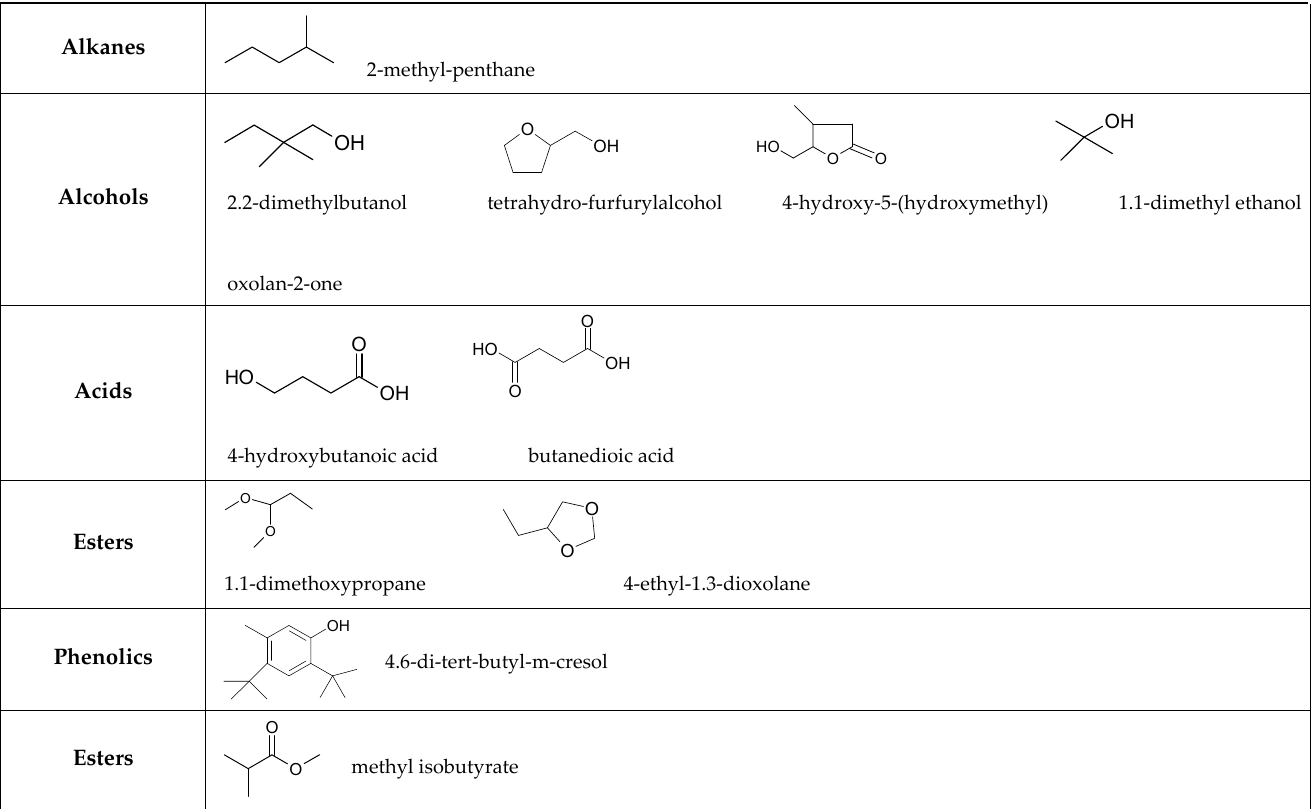
Figure 15. GC-MS spectrum of the humins oil (from the hydrodeoxygenation reaction in the presence Figure 15. GC ‐ MS spectrum of the humins oil (from the hydrodeoxygenation reaction in the pres ‐ of 1.5Pt@USY, at 250 ◦ C, 6 h, and 30 bar of H 2 ). ence of 1.5Pt@USY, at 250 °C, 6 h, and 30 bar of H 2 ). Table 5. Major component classes and representative individual components in the liquid phase Table 5. Major component classes and representative individual components in the liquid phase Table 5. Major component classes and representative individual components in the liquid phase Table 5. Major component classes and representative individual components in the liquid phase analysis by GC-MS. Table 5. Major component classes and representative individual components in the liquid phase Table 5. Major component classes and representative individual components in the liquid phase Table 5. Major component classes and representative individual components in the liquid phase analysis by GC ‐ MS. analysis by GC ‐ MS. analysis by GC ‐ analysis by GC ‐ MS. analysis by GC ‐ MS. analysis by GC ‐ MS.